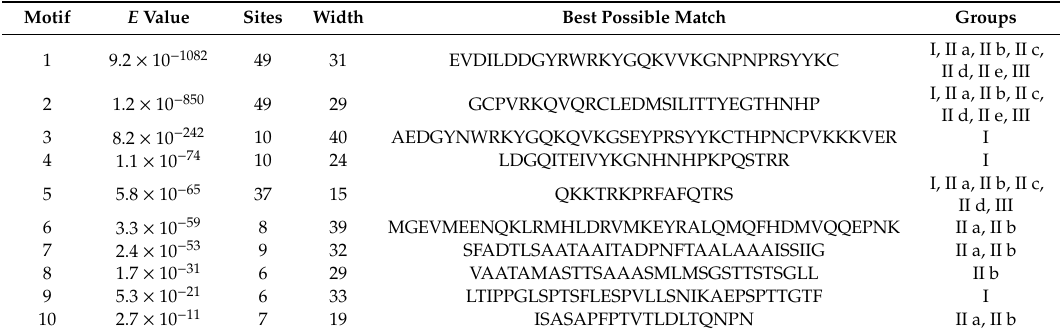
Figure 3. Phylogenetic tree of CcWRKY proteins. The multiple protein sequence alignment was performed using ClustalX2. The NJ (neighbor-joining) tree was constructed in MEGA6 while using a Poisson model with the following options: pairwise deletion, homogeneous pattern, and 1000-replicate bootstrap. Di ff erent clades (or subclades) are indicated by the colors of the branch lines, respectively. The red cycles indicate the gene ID from Arabidopsis, and the blue triangle indicates the gene from C. canephora . Table 1. Conserved motifs identified in the CcWRKY proteins. The underlined letters indicate the conserved WRKY domains and zinc finger motifs.